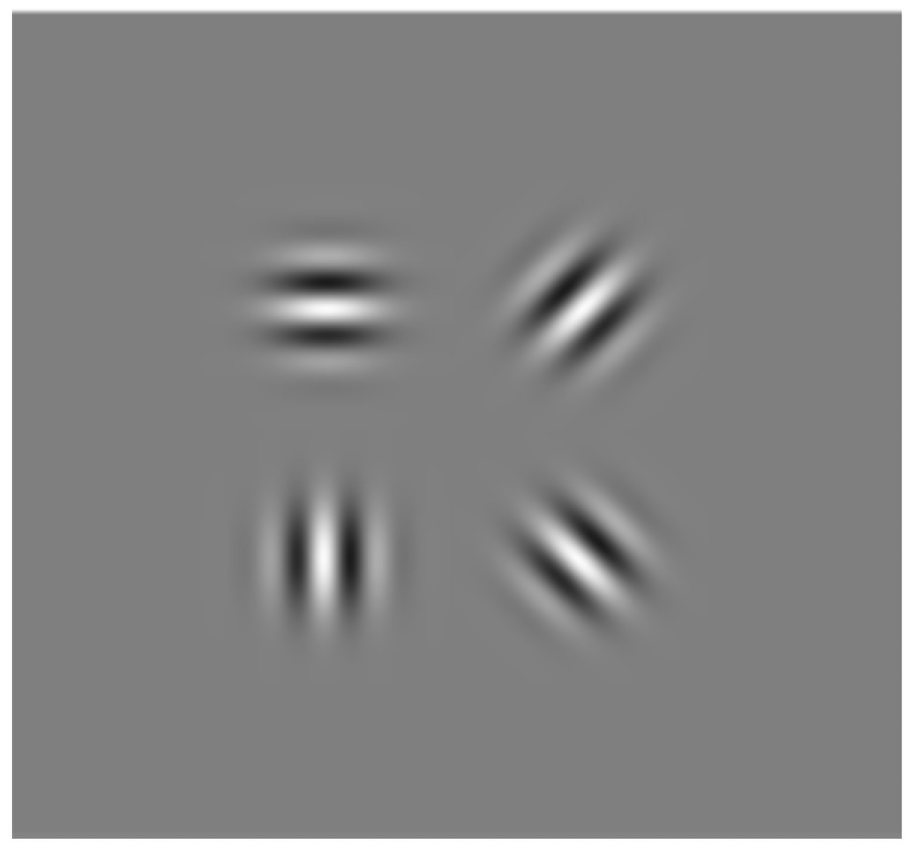
Fig 1. Example of one trial of Adjustment CST consisting of four Gabor patches at four different orientations and a spatial frequency of 6 cpd.